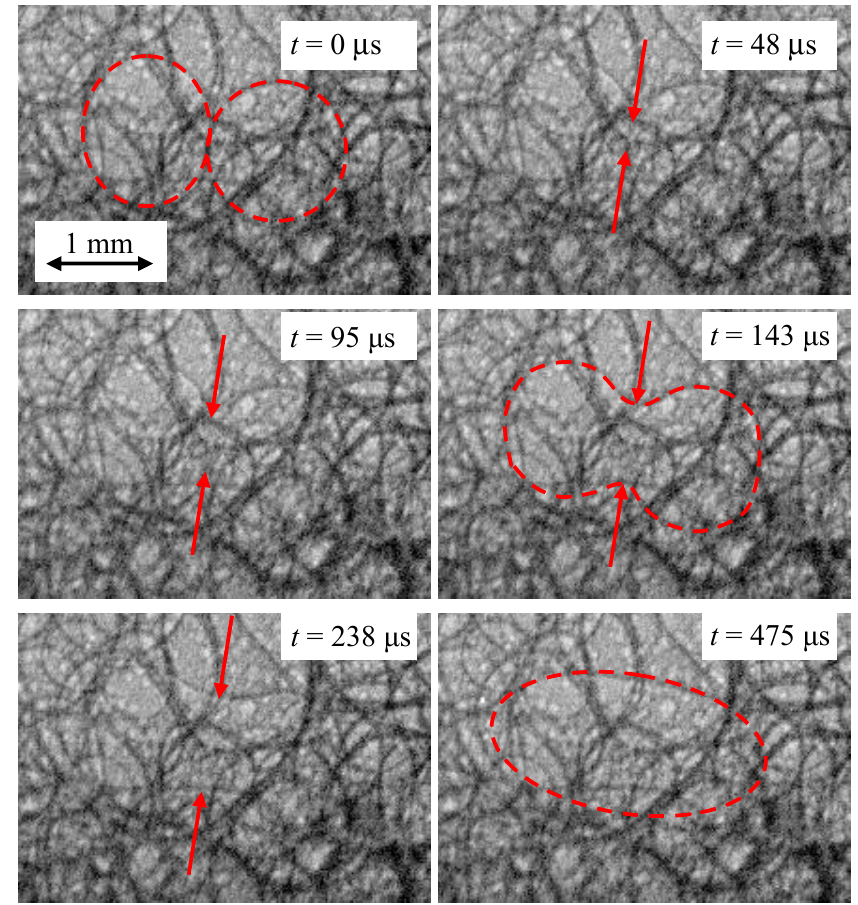
Figure 2. Series of radiographs of an AlSi10 + 0.5 wt.% TiH from an in-situ fast synchrotron X-ray radioscopic analysis (data acquired at beamline ID19 of the European Synchrotron Radiation Facility (ESRF)). The coalescence of two bubbles measured with 9.5 μ s frame interval (105 kfps) can be observed. Dashed lines indicate the contours of the bubbles and arrows indicate the corresponding ruptured cell